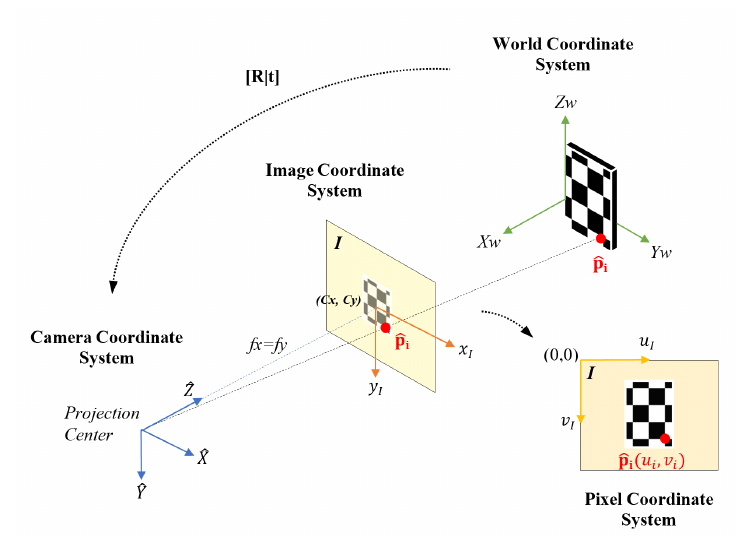
Figure 3. Image projection of the ideal and estimated